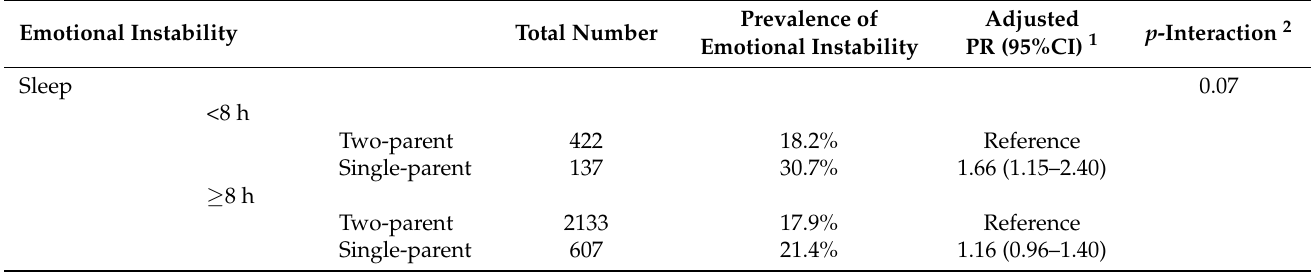
Table 5. Family type and children’s emotional instability: stratified by children’s daily